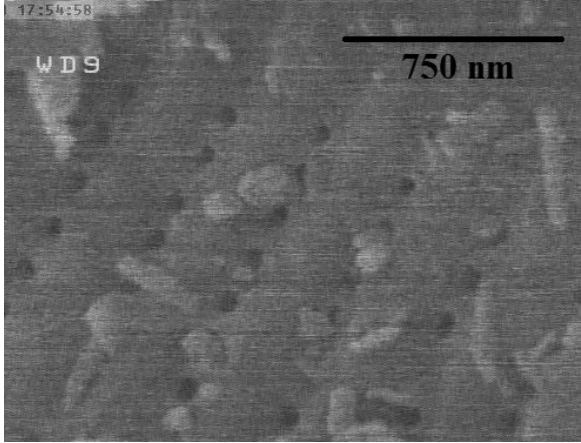
Figure 3 : SEM image of the pristine diatomite sample